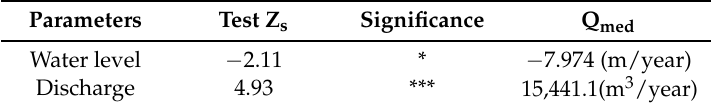
Figure 9. Plot of average precipitation, plant discharge, water level, and energy production at Akosombo dam. The average precipitation of the Volta Basin was estimated using the Thiessen Method. Table 3. Trends test on water level and discharge. Table 3. Trends test on water level and discharge.